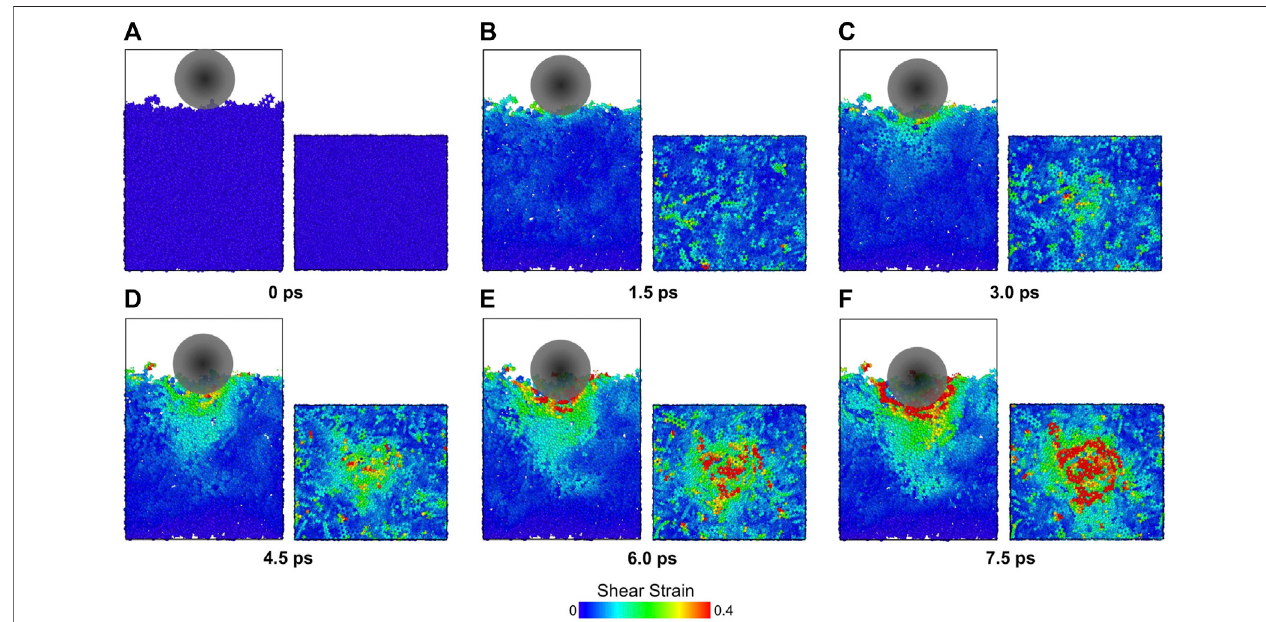
FIGURE 3 | Shear strain distributions of vitrinite atoms during loading at times of (A) 0, (B) 1.5 ps, (C) 3.0 ps, (D) 4.5 ps, (E) 6.0 ps, and (F) 7.5 ps. For each sub- fi gure, the left- and right-hand images show the front cross-sectional and top views of the vitrinite substrate, respectively.